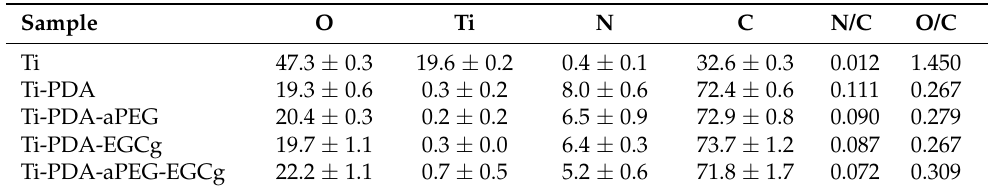
Table 1. Surface composition (% at) of tested samples as detected by XPS analysis. Data show average and standard deviation, three replicates for each